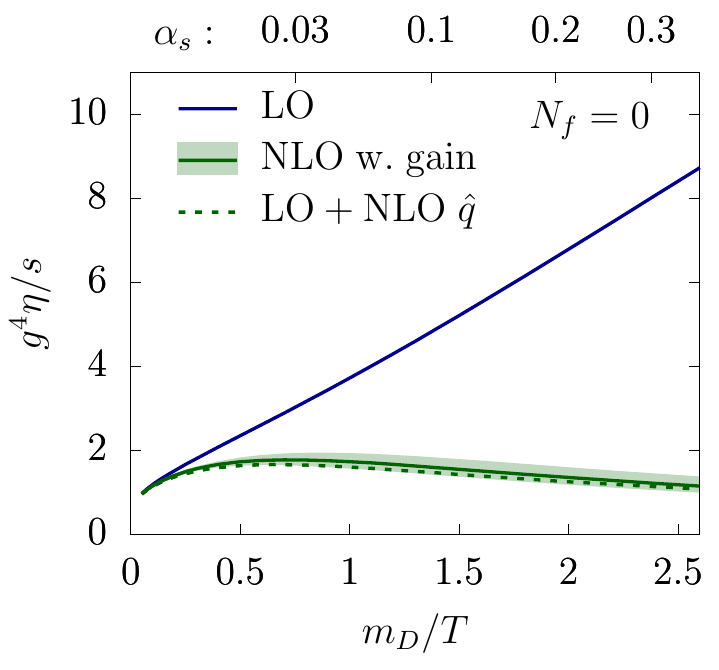
Figure 10 . The (cid:17)=s ratio in units of 1 =g 4 as a function of m The uncertainty band is due to the unknown gain terms described in (cid:12)gure 6. A (cid:12)t for the solid green curve is available in eqs. (D.5) and (D.7). The dashed line shows a partial NLO result with only the NLO modi(cid:12)cations to ^ q